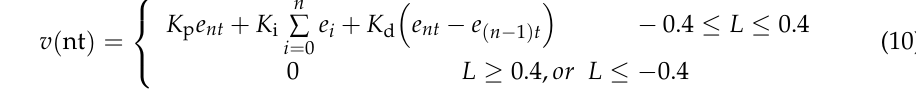
where K p , K i , and K d are the PID parameters; e n is the vertical position deviation, and L is the longitudinal position of the shifting weight defined in O 2 - X 2 Y 2 Z 2 .